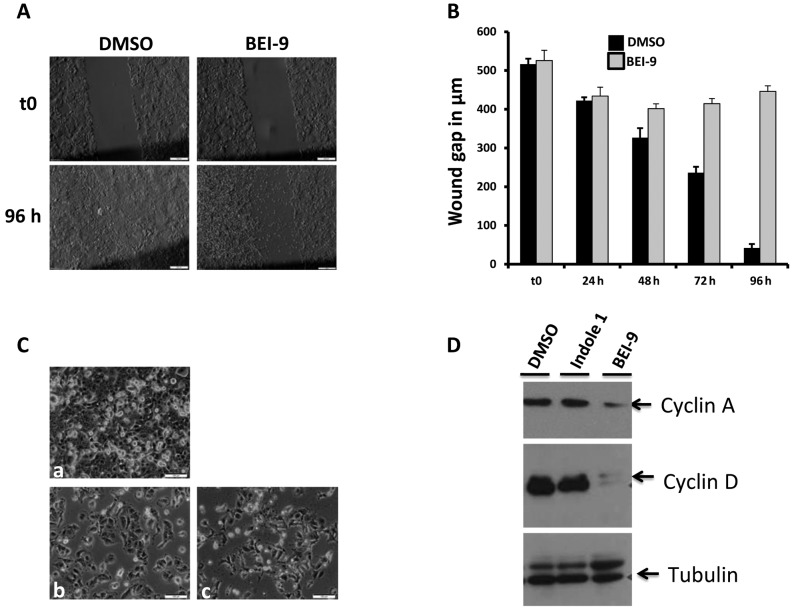
Effects of BEI-9 on motility, survival, recovery from treatment, and cyclin levels in treated cells. (A and B) The scratch wound assay was performed as described in Materials and methods. Phase contrast images of the wounded and then dimethyl sulfoxide (DMSO) or BEI-9 treated SW480 cell monolayers were taken at 24-h intervals. Panel a shows images of the same spots taken immediately after scratching (upper panels) and then 96 h after the first treatment (lower panels). Panel B shows widths of scratch wound gaps measured at 24-h intervals for 96 h. (C) Sparsely seeded SW480 cell monolayers were exposed to either DMSO or BEI-9 (25 µM) for 48 h. Then the monolayers were washed with culture medium and further incubated for up to 4 days. DMSO-treated cells became 100% confluent within 24 h of washing (a), whereas BEI-9-treated cells did not recover from the treatment, as shown on micrographs at the wash time (b) or 4 days after washing (c). (D) SW480 cells were exposed to DMSO, indole 1 (25 µM, inactive), or BEI-9 (25 µM) for 24 h. Protein levels of cyclin A or D were detected by immunoblotting. Tubulin served as a loading control. (E and F) Effects of BEI-9 on HCT116 colon carcinoma cells. The viability of cells exposed for 24 h to the indicated concentrations of BEI-9 was measured with the MTS assay. Absorbance values at 490 nm wavelength are shown on the y-axis (E). Photomicrographs of cells exposed for 48 h to DMSO or BEI-9 (0.2, 1, 5, or 10 µM) are shown (F).